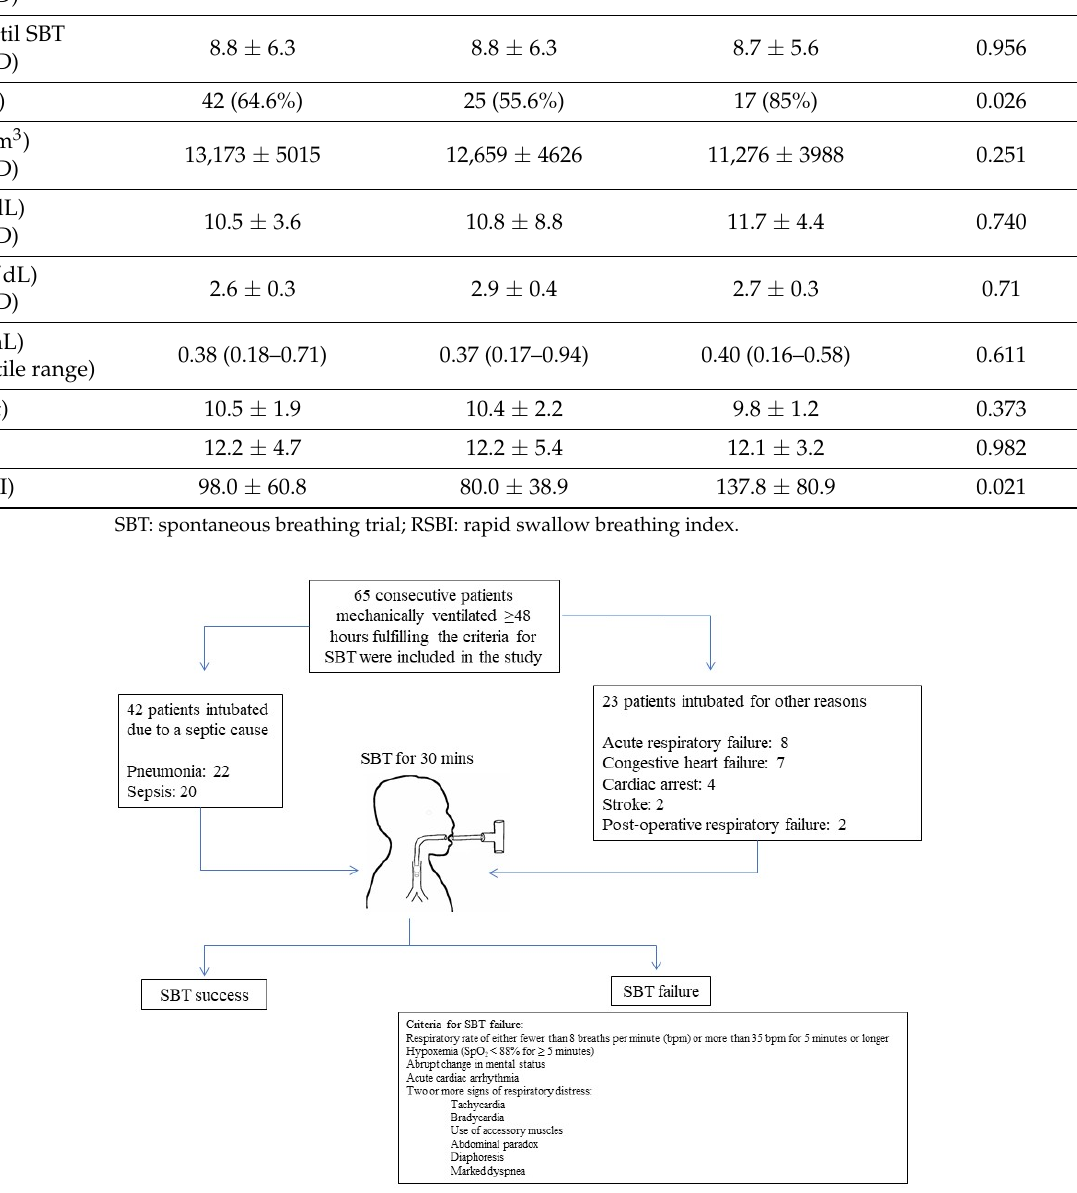
Figure 1. Consort diagram of patient screening.